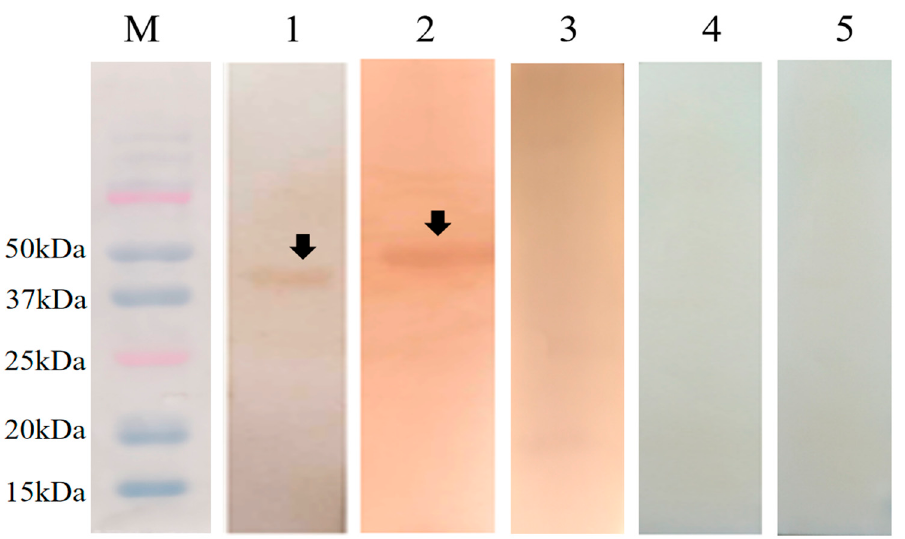
Figure 4. Western blotting analysis of r EmSAG10 and r EmSAG11. M: Bio-red protein molecular weight standard; lanes 1 and 2 were the identified as r EmSAG10 and r EmSAG11 in the rabbit serum infected with E. magna ; Lane 3 was the identified as the pET-32a tag protein protein in the rabbit serum infected with E. magna ; lanes 4 and 5 were identified as r EmSAG10 and r EmSAG11 in the rabbit-negative serum for E. magna without infection.